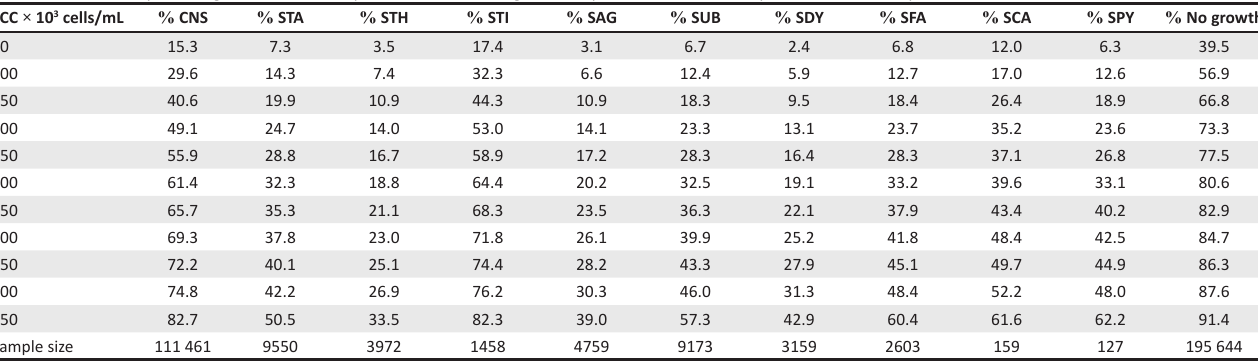
TABLE 5: Cumulative percentages of 10 bacteria species and culture-negative samples isolated from composite cow milk samples distributed on various cell count thresholds. SCC × 10 3